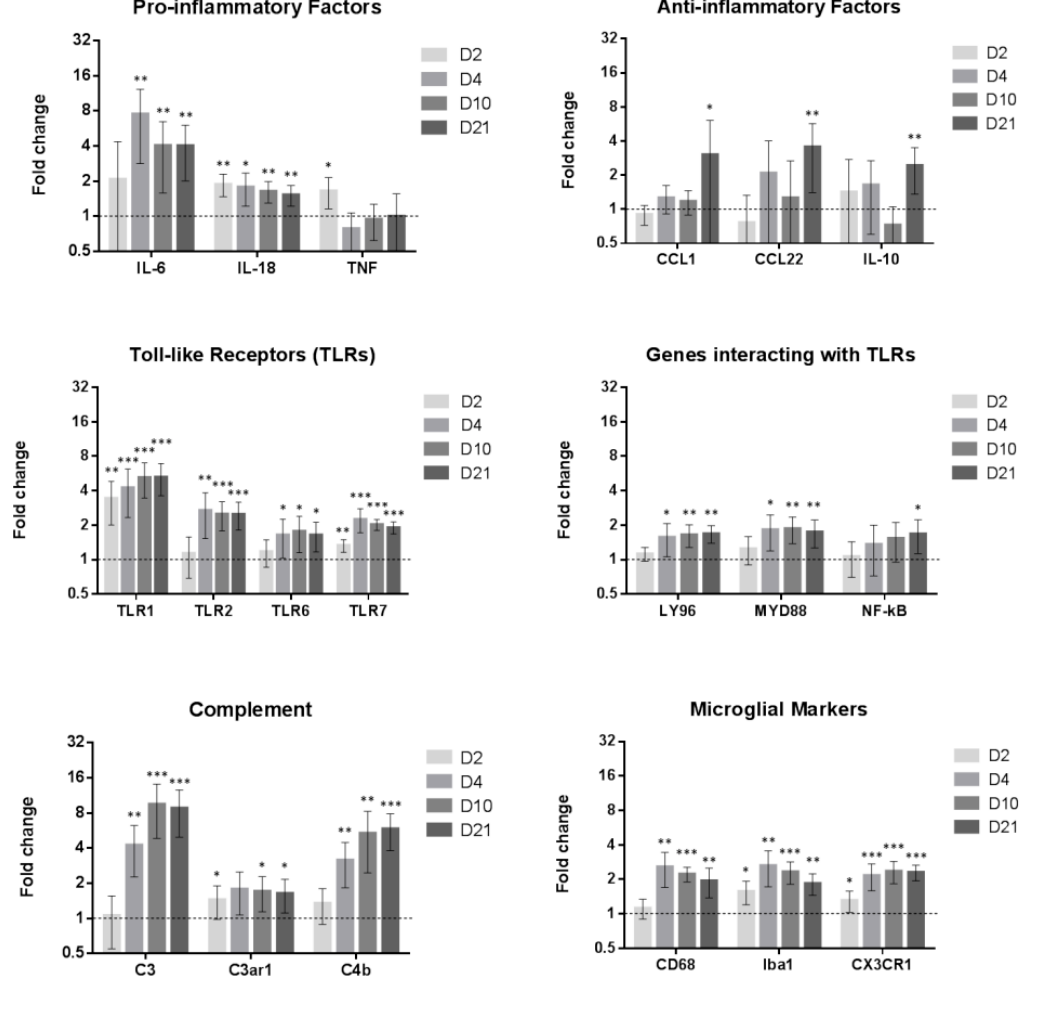
Figure 4. Gene regulation in the spinal cord following SNI. RT-qPCR array with fold change of gene expression in adult male rat ipsilateral dorsal horns at D2, D4, D10 and D21 after SNI compared to naive animals. Values are expressed as mean ± 95% CI. Dotted line at one fold regulation (naive animals). * p < 0.05, ** p < 0.01, *** p < 0.001. Student’s t -test: Naive (not shown) vs SNI. N = 6 for each time point (D2, D4, D10 and D21).